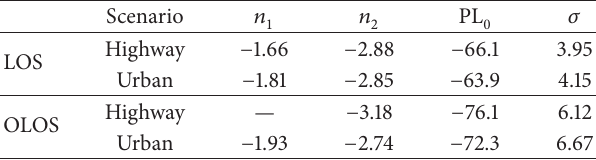
Figure 6: Measured channel gain for the urban environment and the least square best fit to the deterministic part of (4). Table 2: Parameters for the dual-slope path loss